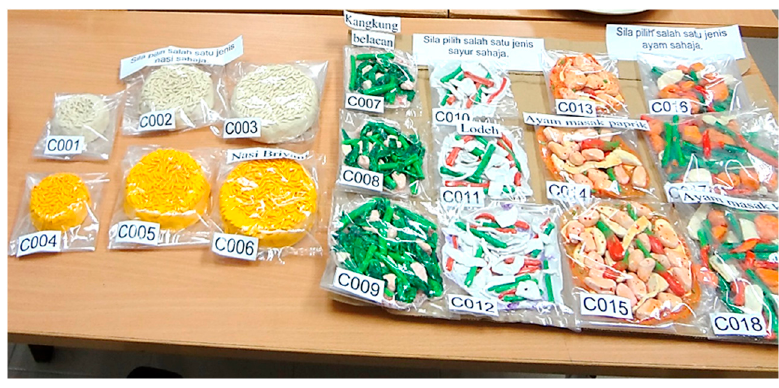
Figure 2. Food models for foodscapes preferences—colour criterion.